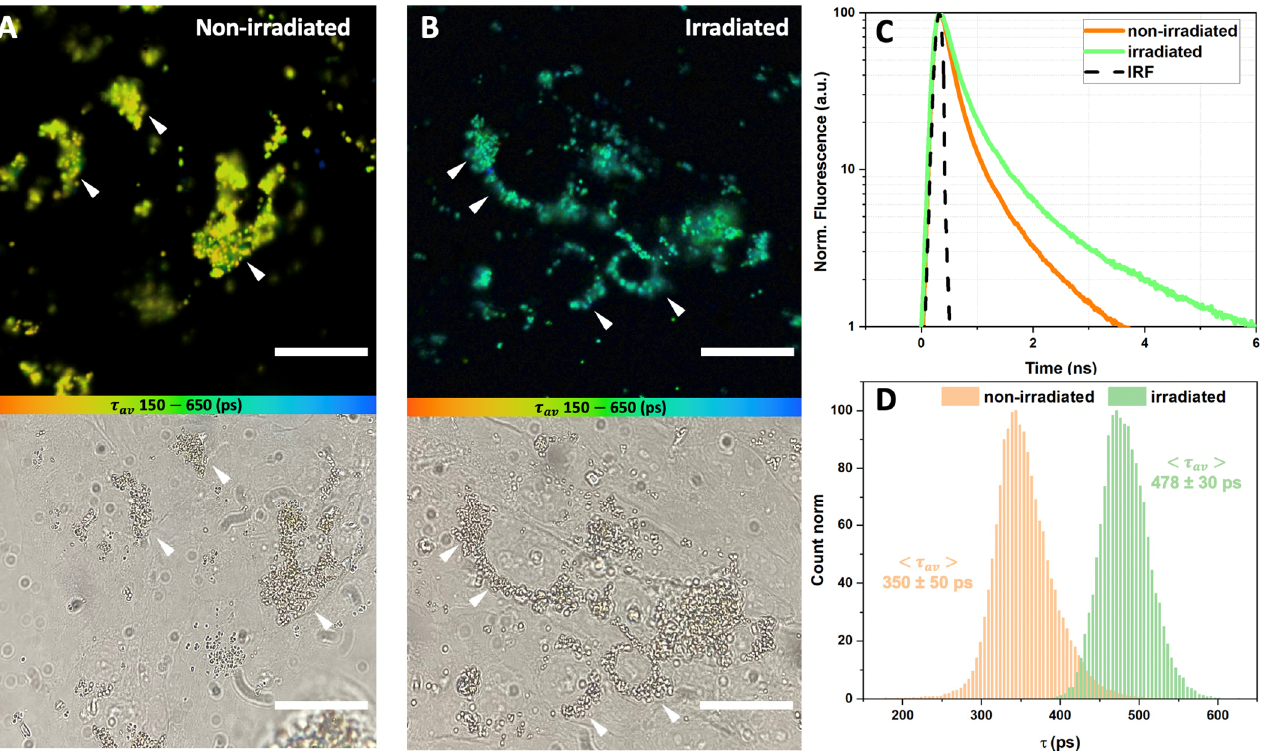
Figure 3. FLIM data on ARPE-19 cells fed with lipofuscin granules, measured immediately after exposure to white light. Excitation λ exc: 473 nm; detection λ det: 485 (long pass) nm; color scale encodes the range of average lifetimes from 150 ps (orange) to 650 ps (blue). ( A ) FLIM and transmitted microscopy images of non-irradiated cells; ( B ) FLIM and transmitted microscopy images of irradiated cells; ( C ) fluorescence decay curves averaged for the set of the curves calculated in each pixel of the corresponding image; ( D ) distribution of the fluorescence lifetime in each pixel of the image. Average fluorescence lifetime values ( < τ av > ) were obtained by approximation of distributions with the Gauss function, with errors corresponding to the width of the Gaussian. White arrows correspond to the deposition of LG in ARPE-19 cells. The measuring bar corresponds to 10 µm.